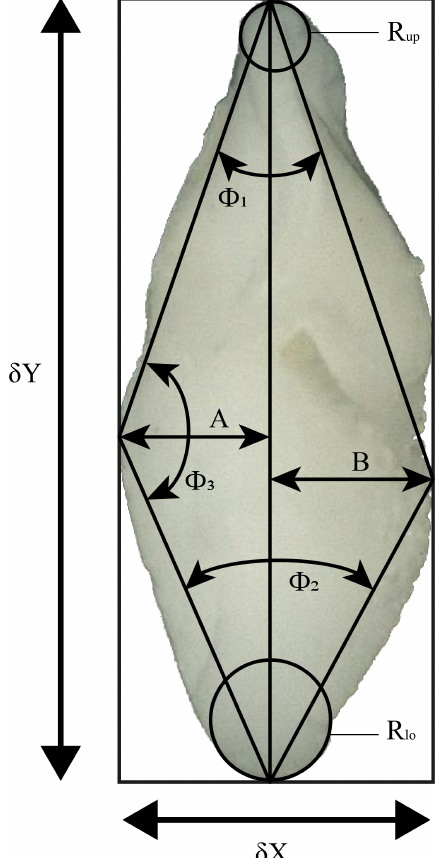
Figure 3. Investigated morphometric parameters. δX : spiral height; δY : axial length; (cid:56) 1 : upper keel angle; (cid:56) 2 : lower keel angle; (cid:56) 3 : angle at the apex; A: spiral convexity; B: umbilical convexity; R up : radius of the osculating circle in upper keel region; R lo : radius of the osculating circle in lower keel